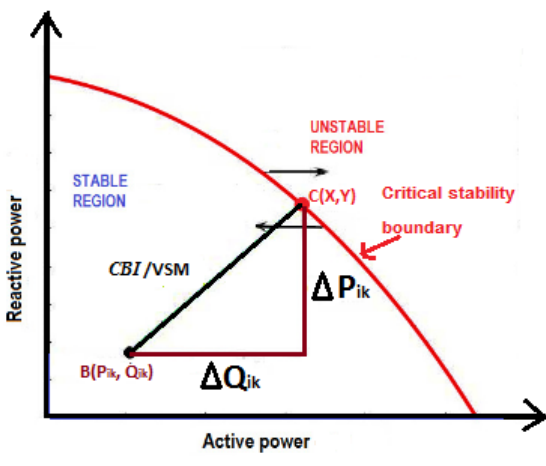
Figure 3. P-Q curve showing the transmission line voltage stability